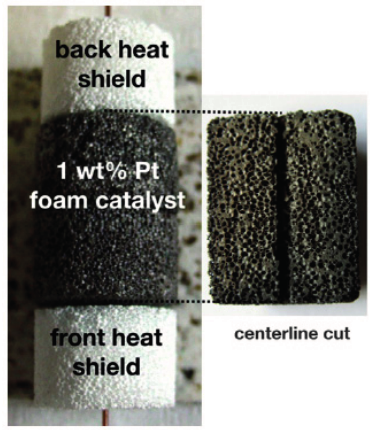
Figure 4. Platinum coated monolithic catalyst